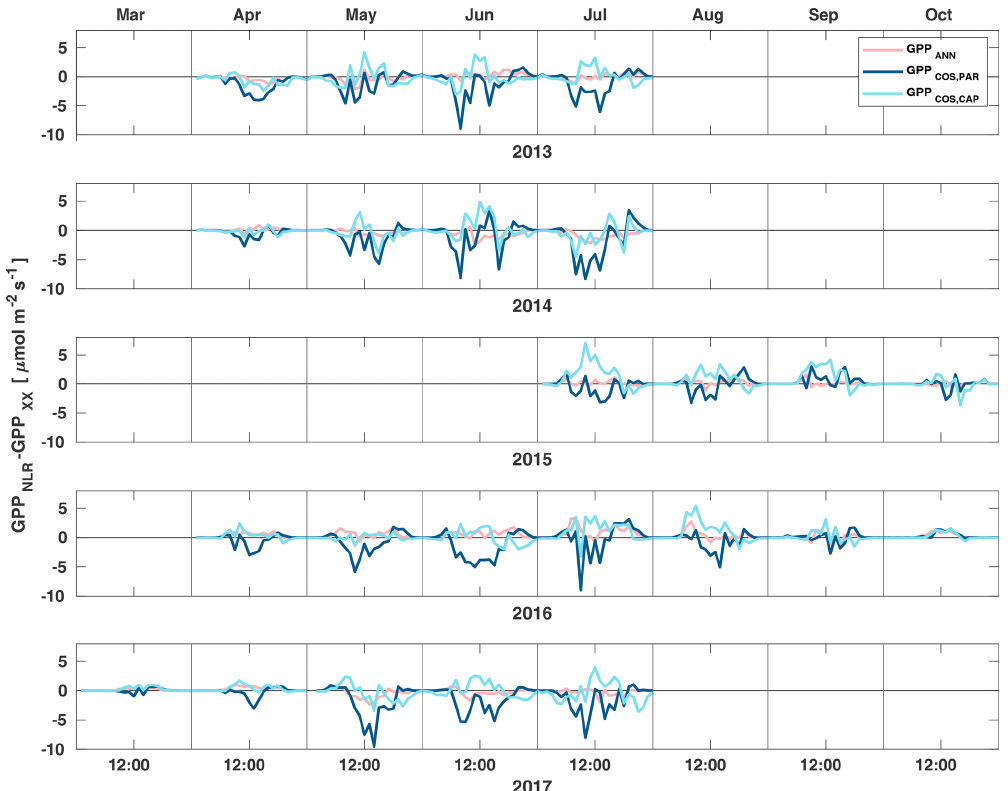
Figure 3. Diurnal variation of the difference of GPP ANN (pink), GPP COS,PAR (dark blue) and GPP COS,CAP (light blue) to the reference GPP NLR in different months during the measurement period 2013–2017. Averaging was done to the same data points and only months with more than 55% of data coverage were